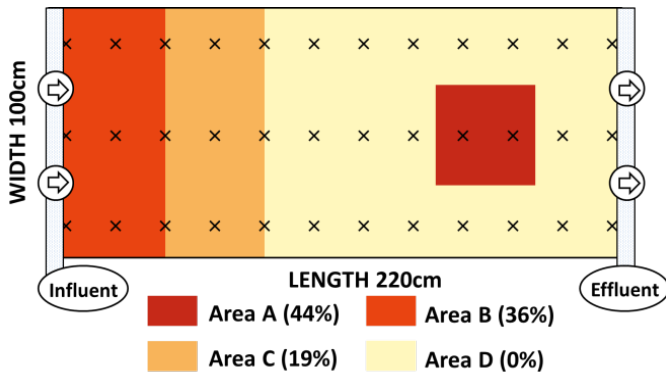
Figure 2. Schematic diagram of lab scale horizontal subsurface flow constructed wetland (HSSF CW) (plan view; different colors represent various sediment fractions ( v / v ); the crosses represent the positions of stainless-steel bar electrodes; the arrows represent the flow direction).